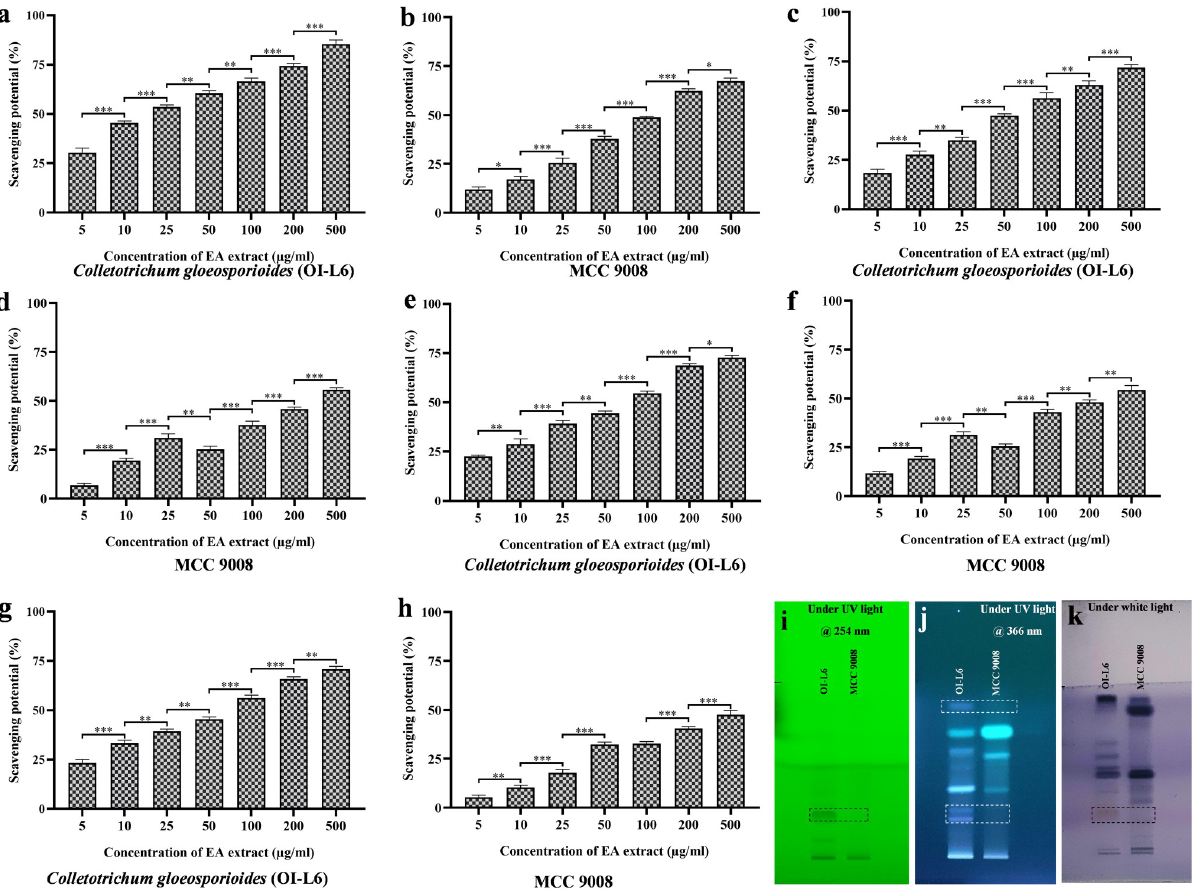
Fig 9. Comparative antioxidant activity and HPTLC fingerprint profiling of EA extract of C . gloeosporioides . (a, b) Free radical scavenging potential of OI-L6 and MCC 9008, (c, d) Superoxide anion scavenging potential of OI-L6 and MCC 9008, (e, f) Nitric oxide scavenging potential of OI-L6 and MCC 9008, (g, h) Hydroxyl radical scavenging potential of OI-L6 and MCC 9008, ( i) TLC plate scanned at 254 nm, (j) TLC plate scanned at 366 nm, (k) TLC plate under white light after derivatization with anisaldehyde sulphuric acid reagent. MCC 9008: C . gloeosporioides , associated